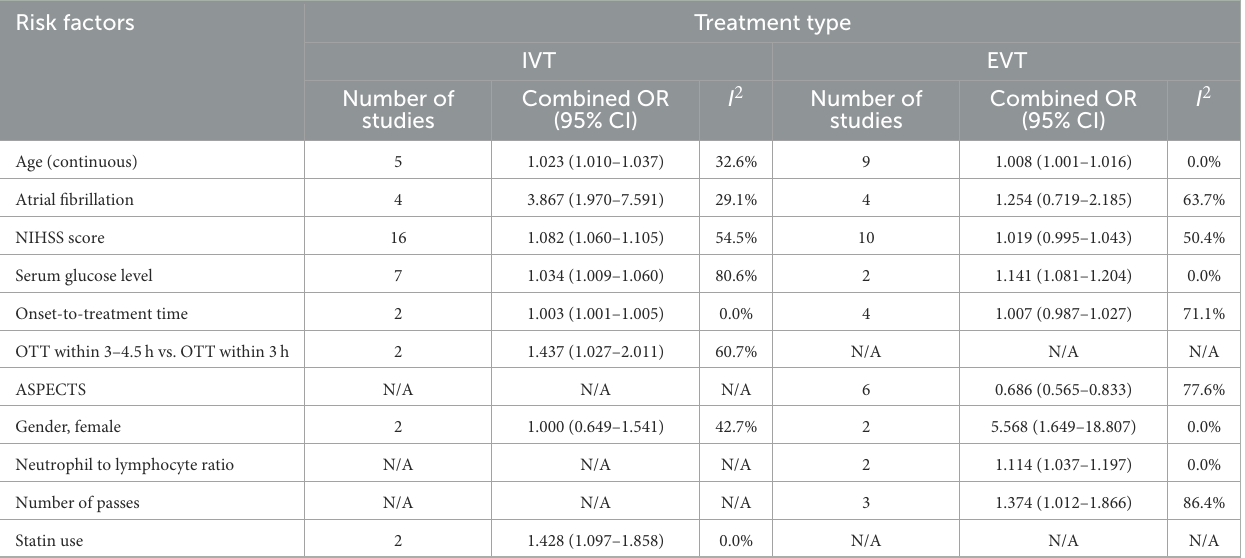
TABLE 5 Predictors for sICH in acute ischemic stroke patients: IVT vs.